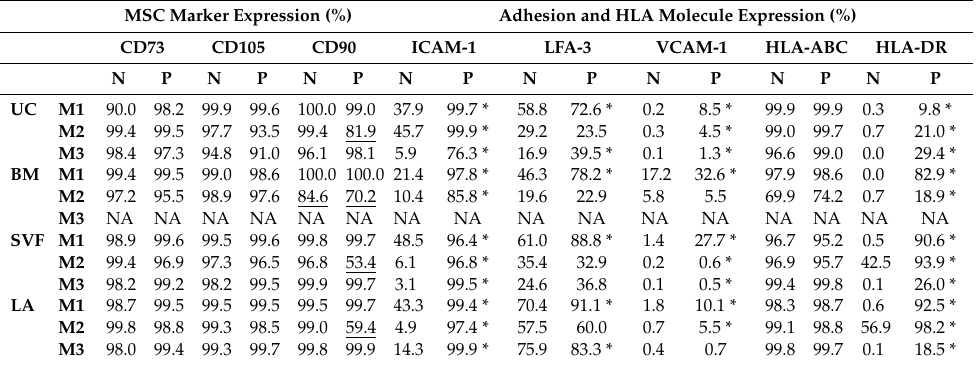
Table 1. Expression of MSC markers and adhesion and HLA molecules in tissue-specific MSC-based MPs. Expression was determined in normal (N) and primed (P) MPs expanded in M1, M2 and M3 media. Results refer to the mean, n = 3. For MSC markers, underlined numbers indicate expression below 90 per cent; for adhesion and HLA molecules, * indicates expression increase in primed MPs compared to normal MPs (unpaired t test, p < 0.05). NA—not available. MSC Marker Expression